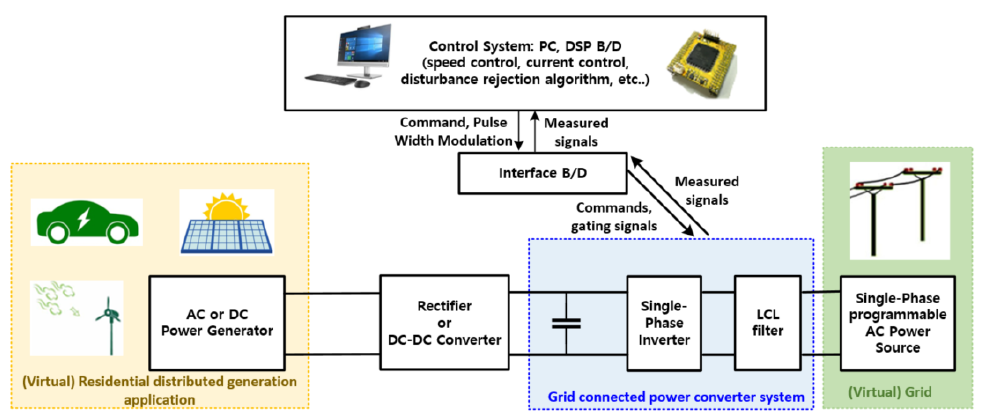
Figure 1. A graphical representation of residential distributed generation with a single-phase GCI control system.